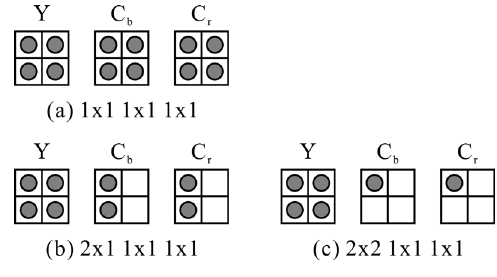
Figure 3. Downsampling (chroma subsampling)